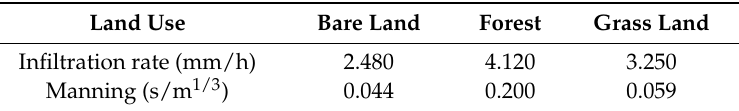
Figure 2. Different land use scenarios on the left-hand side slope. ( a ) Case 1; ( b ) Case 2; ( c ) Case 3. Table 1. The parameters for different land use.